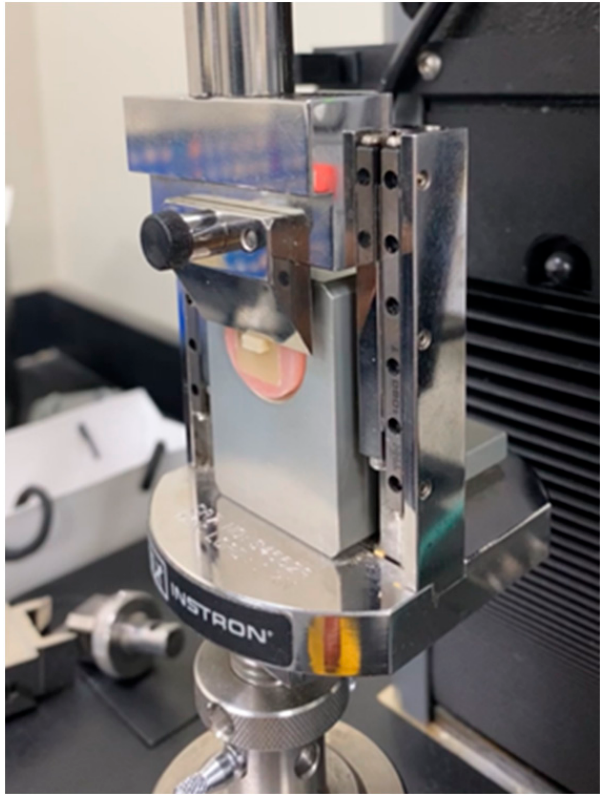
Figure 2. Shear bond strength testing using an Instron testing machine.